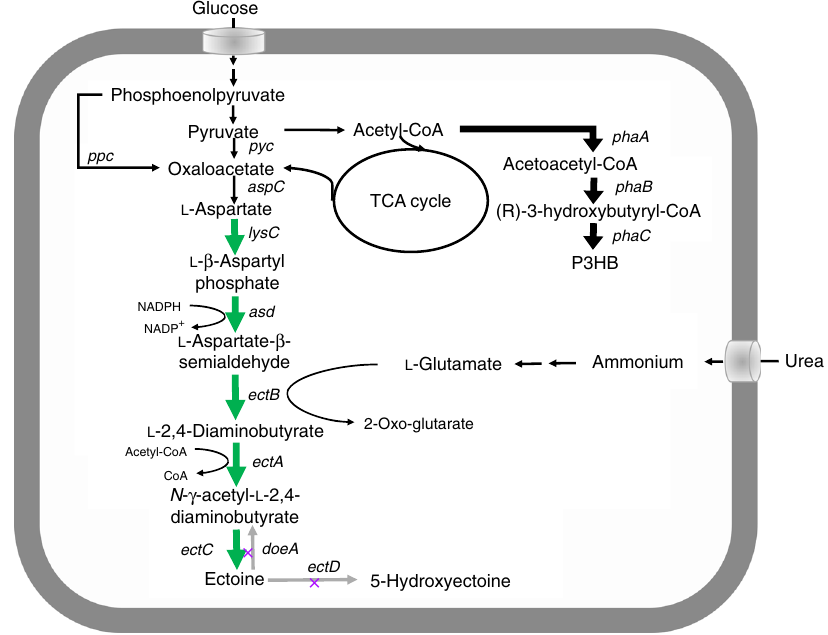
Fig. 1 Metabolic engineering for ectoine and PHB co-production by H. bluephagenesis TD1.0. Endogenous metabolic fl uxes of high ef fi ciency involved in PHB synthesis are shown in black bold lines. Fine-tuned ectoine biosynthesis pathway for enhanced production is shown in green bold lines. Genes doeA and ectD putatively encoding ectoine hydrolase and ectoine hydroxylase, respectively, are deleted to reduce ectoine degradation. phaA , 3-ketothiolase; phaB , NADPH (or NADH)-dependent acetoacetyl-CoA reductase; phaC , PHA synthase; ectA , L -2,4-diaminobutyrate acetyltransferase; ectB , L -2,4- diaminobutyrate transaminase; ectC , ectoine synthase; asd and lysC encoding L -aspartate-semialdehyde-dehydrogenase and aspartokinase, respectively, are cloned from Corynebacterium glutamicum